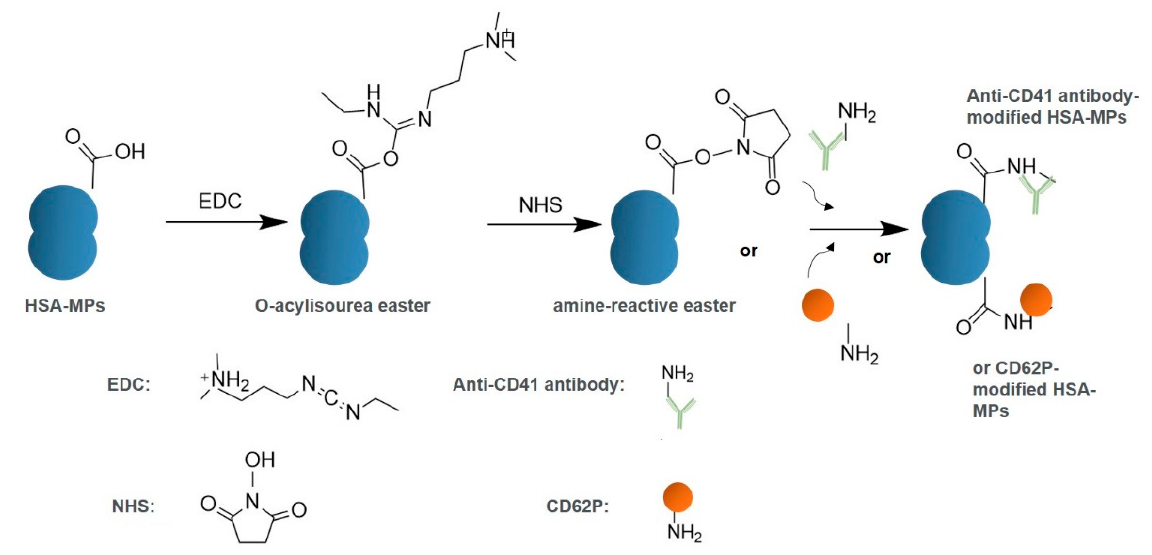
Figure 7. Scheme of modification on the surface of HSA-MPs by EDC/NHS method.